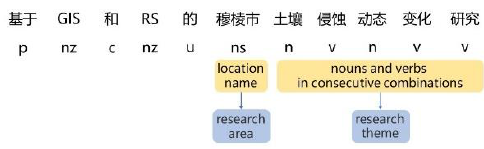
Figure 3 . Spatio-temporal information extraction.